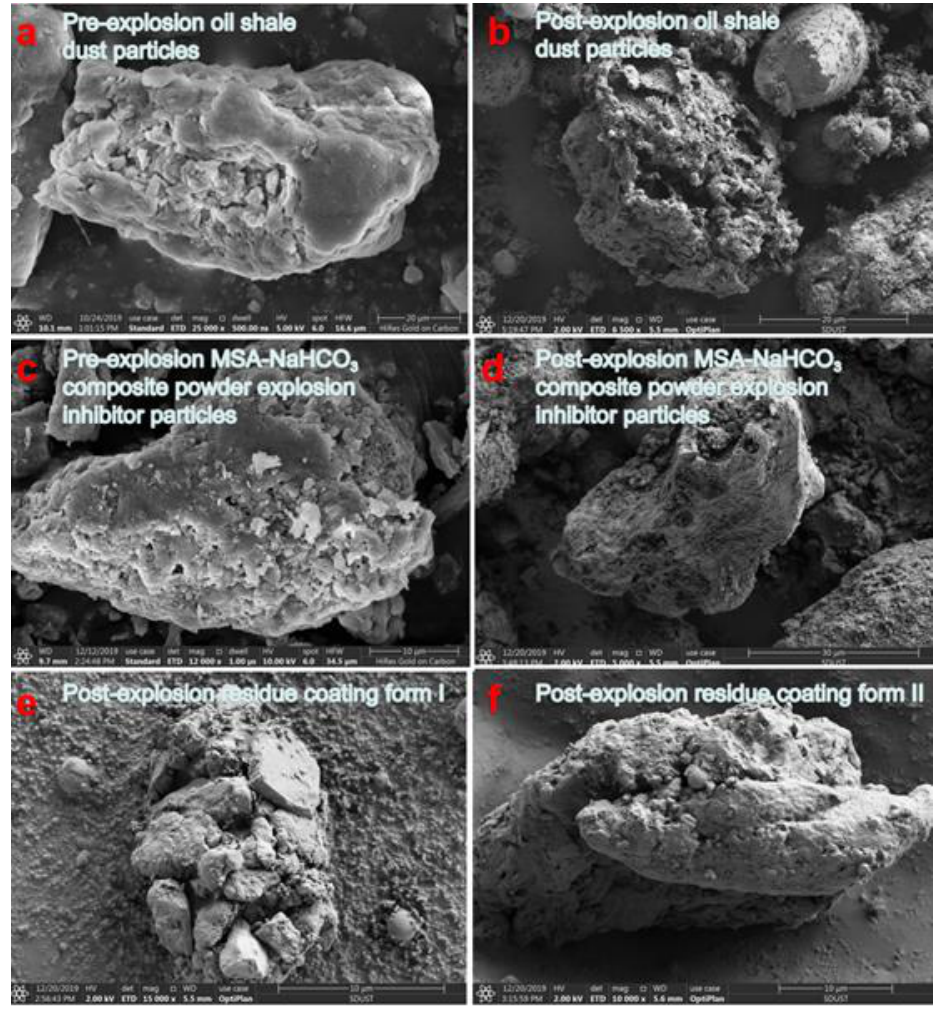
Figure 12. The SEM image of explosion residues after explosion inhibition. ( a ) Pre-explosion oil shale dust particles; ( b ) Post-explosion oil shale dust particles; ( c ) Pre-explosion MSA-NaHCO3 composite poeder explosion inhibitor particles; ( d ) Post-explosion MSA-NaHCO3 composite powder explosion inhibitor particles; ( e ) Post-explosion residue coating form1; ( f ) Post-explosion residue coating